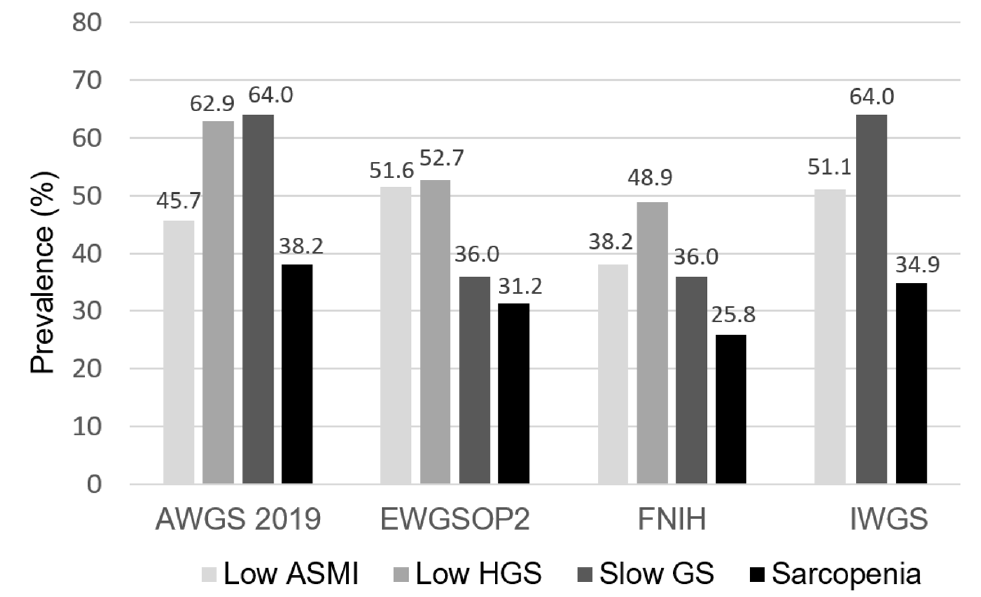
Figure 1. The prevalence of low ASMI, low HGS, slow GS, and sarcopenia across four sarcopenia criteria among patients undergoing PD. ASMI, appendicular skeletal muscle index; HGS, handgrip strength; GS, gait speed; AWGS, Asian Working Group for Sarcopenia; EWGSOP, European Working Group on Sarcopenia in Older People; FNIH, Foundation for the National Institutes of Health; IWGS, International Working Group on Sarcopenia. Table 3. The correlations of SARC-F, SARC-CalF, and CC with anthropometric and skeletal muscle measurements.